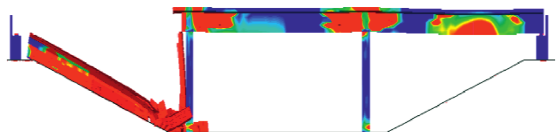
Figure 25: Principal normal strain at the end of the analysis, “model A3-M-N.”